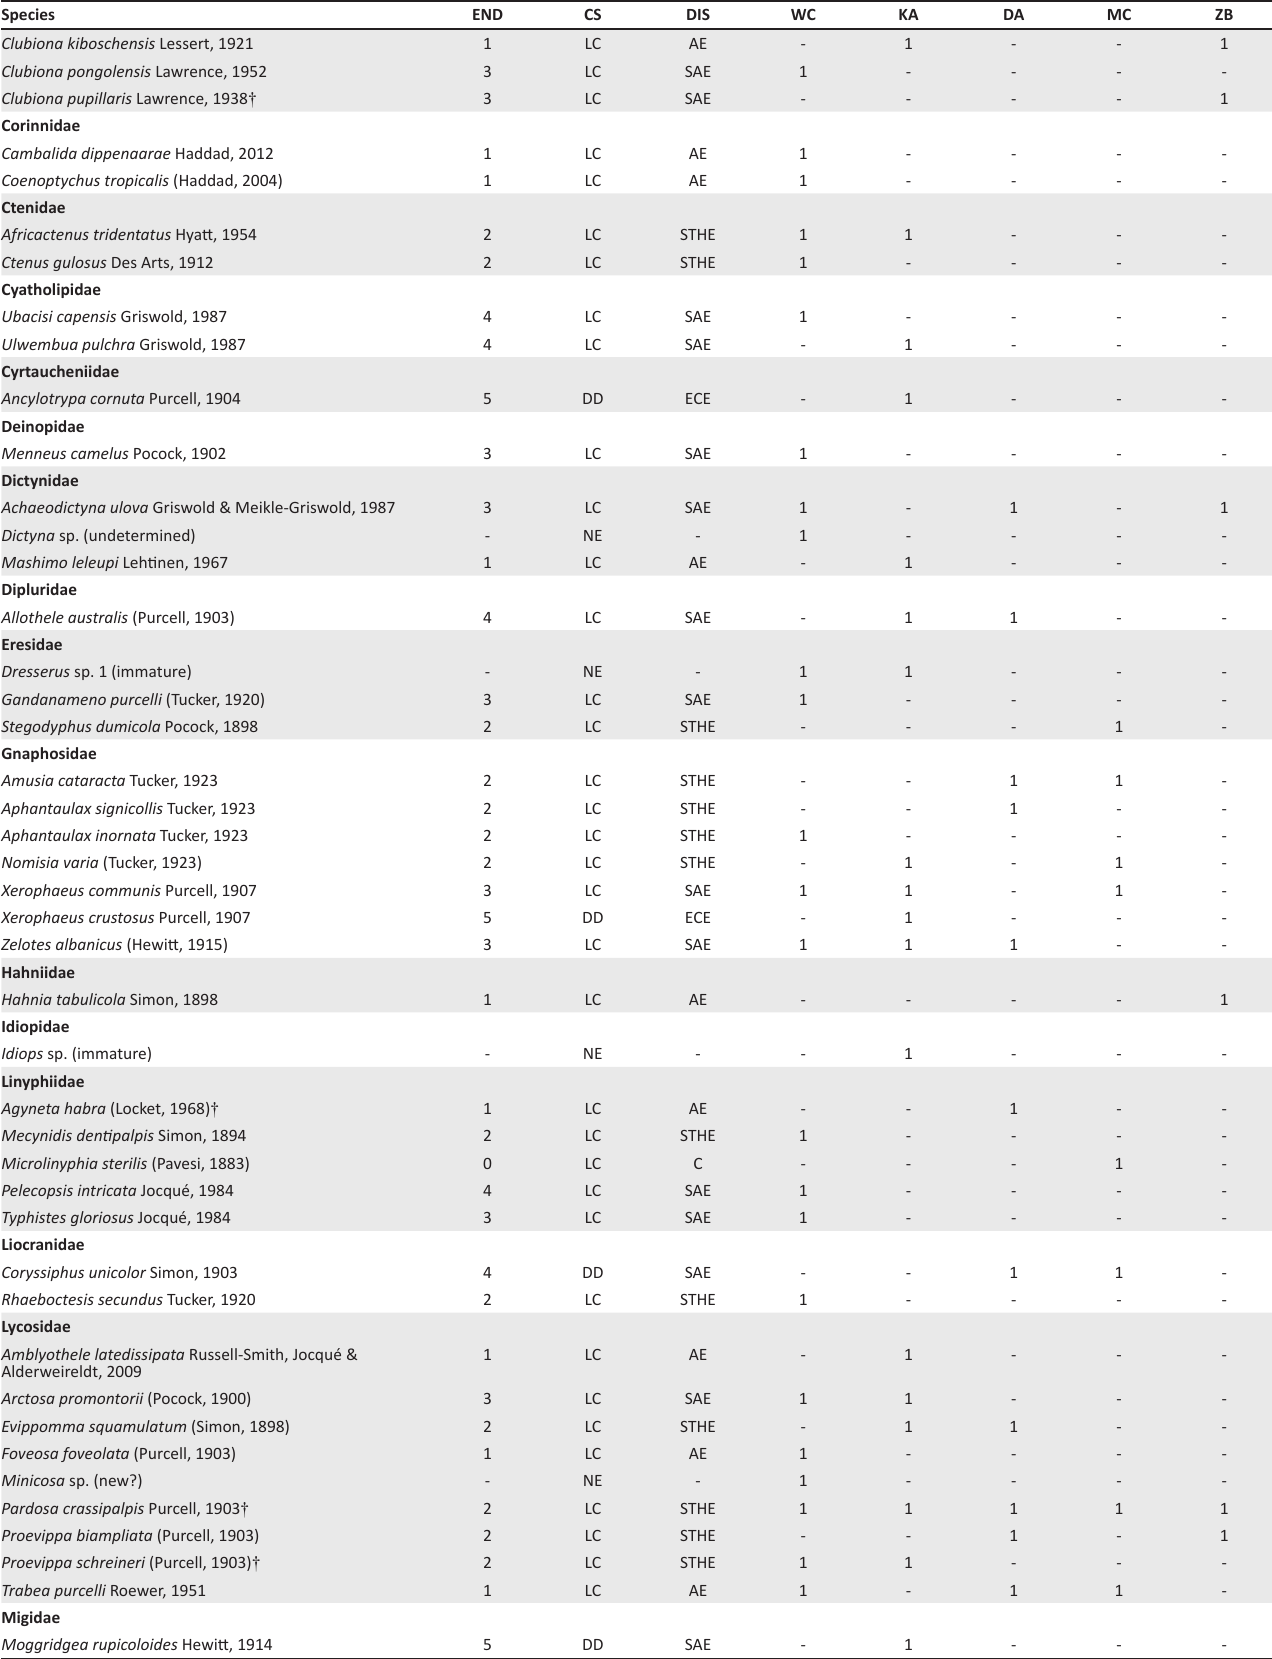
TABLE 1-A1 (Continues): Spiders of the Addo Elephant National Park, listing their endemicity, conservation status, distribution and areas sampled in the park.